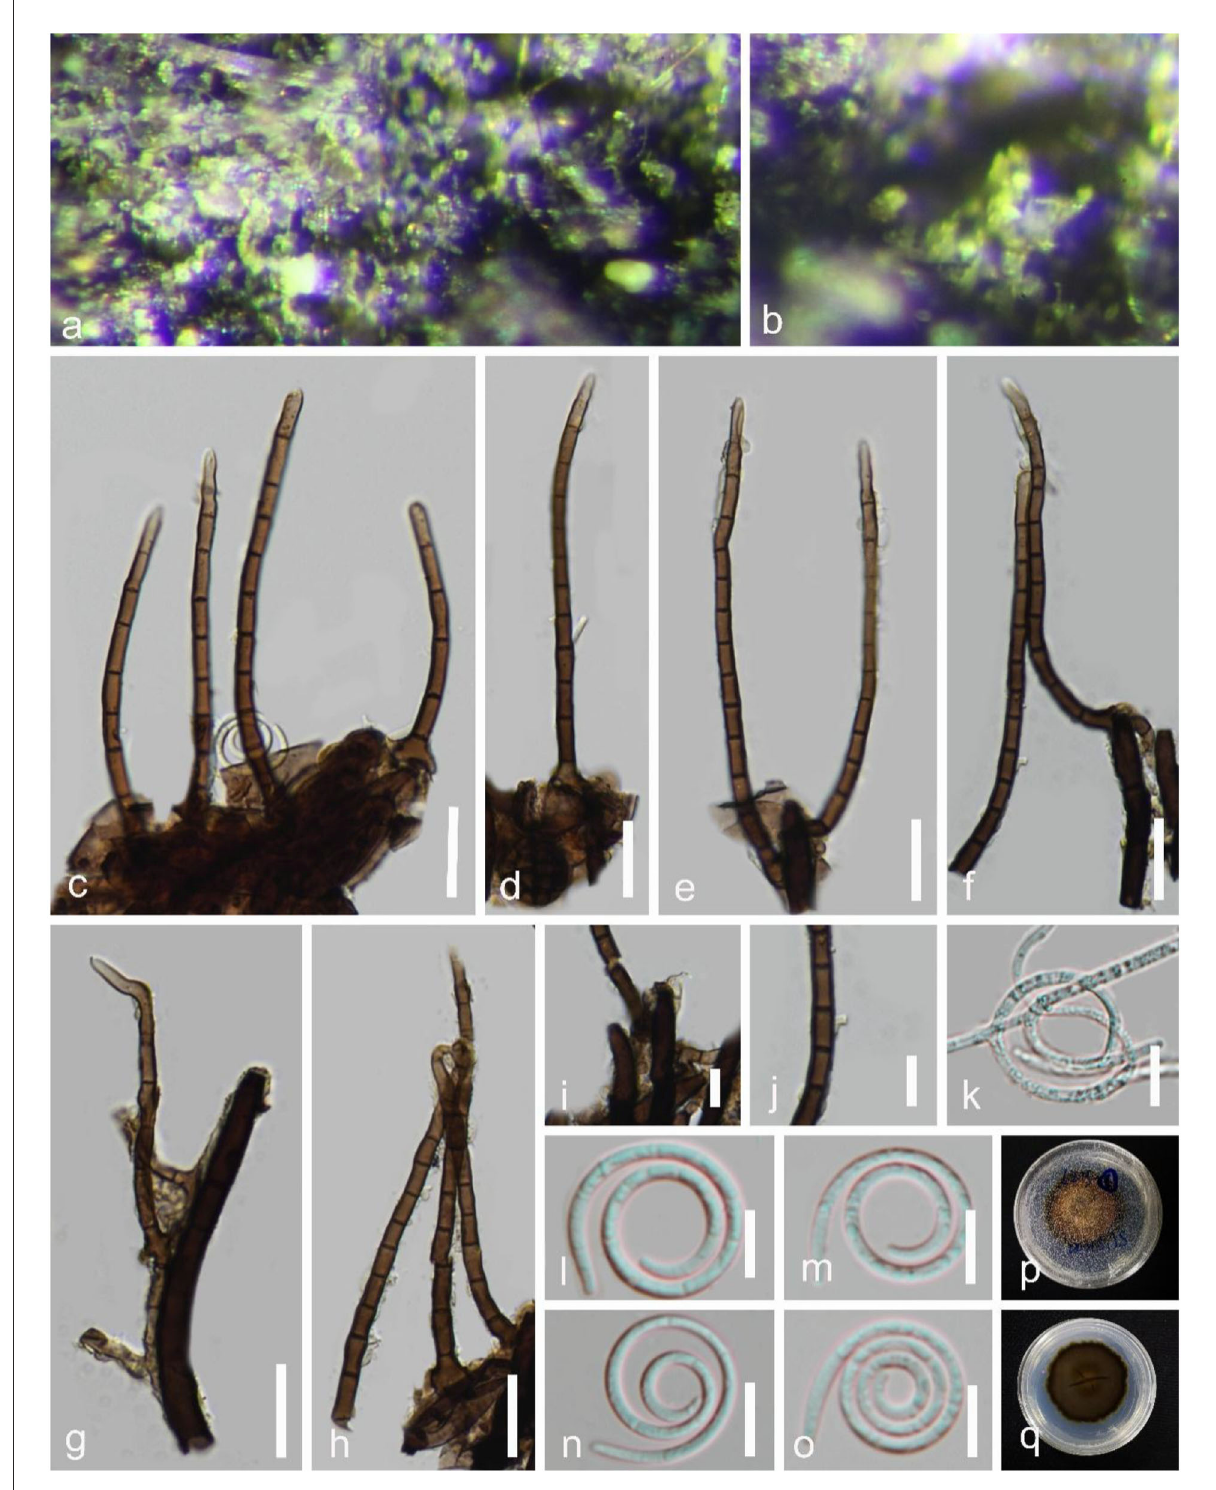
FIGURE7 Helicosporium sexuale (GZAAS 22-2007). (a,b) Colony on decaying wood. (c–h) Conidiophores. (i,j) Conidiogenous cells. (k) Germinating conidium. (l–o) Conidia. (p,q) Colonies on PDA observed from above and below. Scale bars: (c–h) = 20 µ m, (i–o) = 10 µ